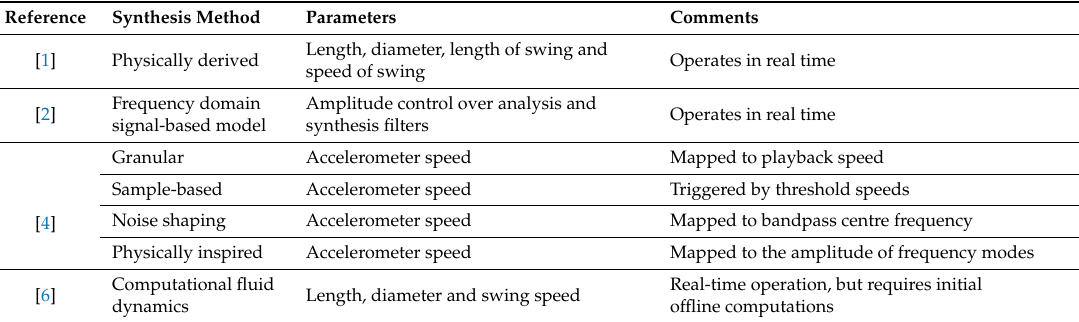
Table 1. Table highlighting different synthesis methods for swing